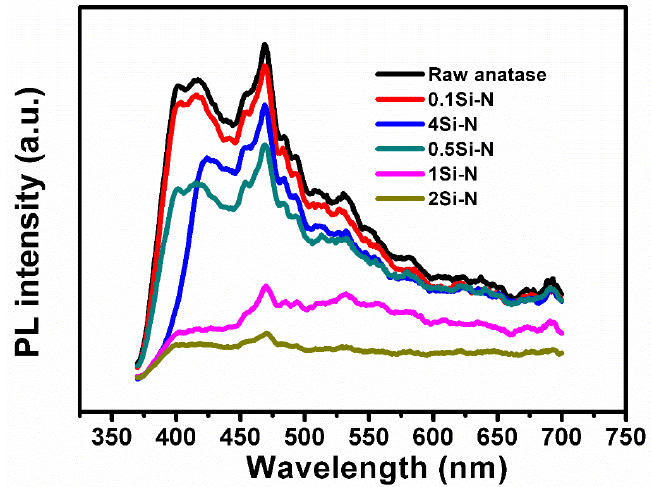
Figure 8. Photoluminescence properties (emission spectra) of the produced samples and comparison with raw anatase TiO 2 powder.